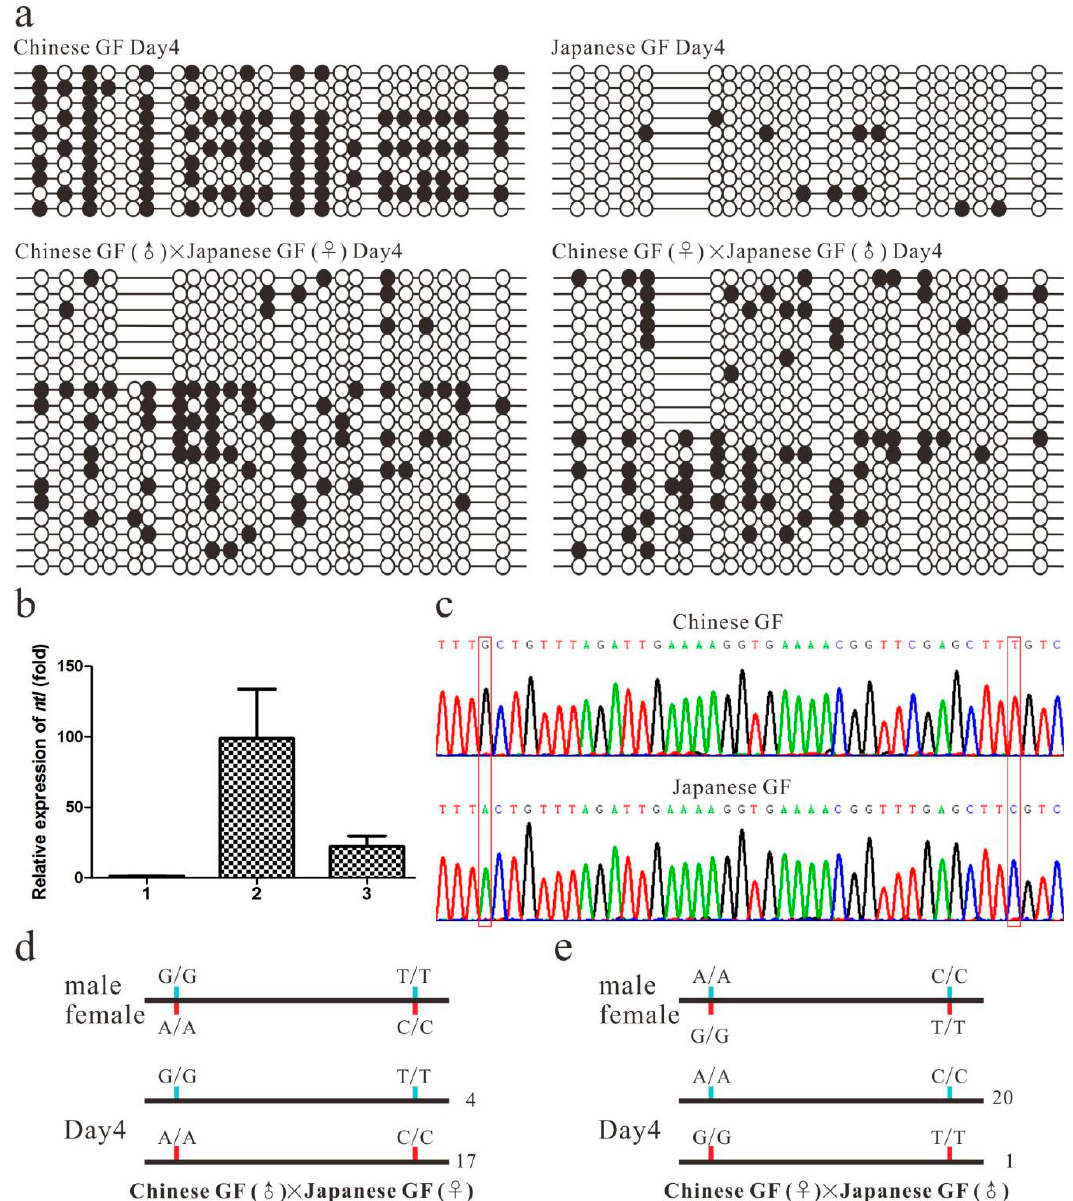
Figure 4. ASM and ASE of the ntl allele in the advanced embryos of the hybrid. ( a ) The methylation status of the Chinese GF ( C. auratus auratus ) and Japanese GF ( C. auratus cuvieri ) ntl CpG island in control strains and reciprocal crosses at the late embryonic stage. ( b ) The expression level of ntl gene in control strains and reciprocal crosses at the late embryonic stage. 1 represents Chinese GF, 2 represents Japanese GF, 3 represents the mix of both reciprocal crosses. ( c ) Two SNP sites in the 3'-untranslated region of the Chinese GF and Japanese GF ntl mRNA. The red boxes indicate the SNP sites. ( d ) and ( e ) Transcription difference of Chinese and Japanese GF-derived ntl alleles in the advanced embryos of both reciprocal crosses. The red and blue color lines indicate female- and male-derived clones, respectively. More than 20 clones of RT-PCR products were sequenced. Numbers at the right of each horizontal line in C and D indicate the number of clones identified in the sequenced clones. The Chinese and Japanese GF-derived ntl CpG island clones in the hybrid can be distinguished with the insertion/deletion genetic marker.